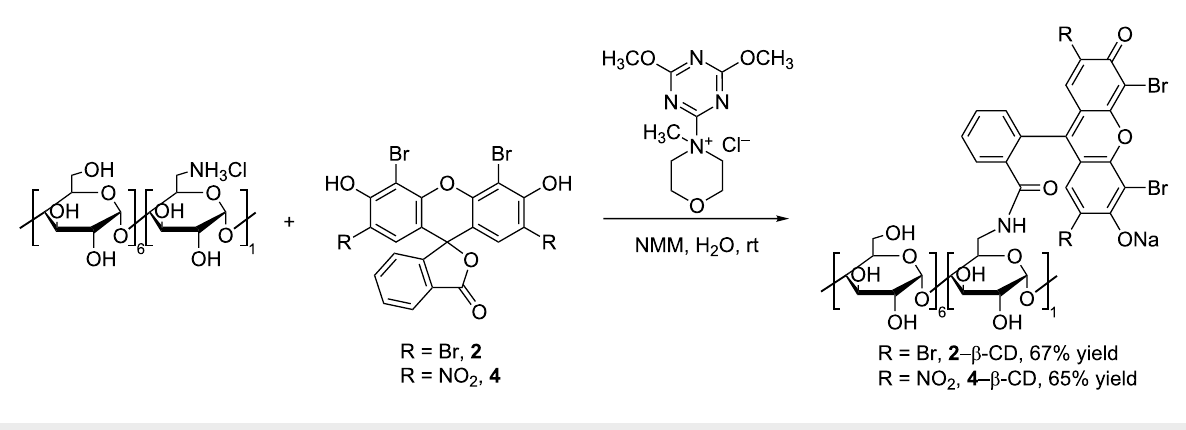
Figure 2: Reaction scheme for the synthesis of eosin-appended β -CDs, 2 – β -CD and 4 – β -CD (NMM: N -methylmorpholine).